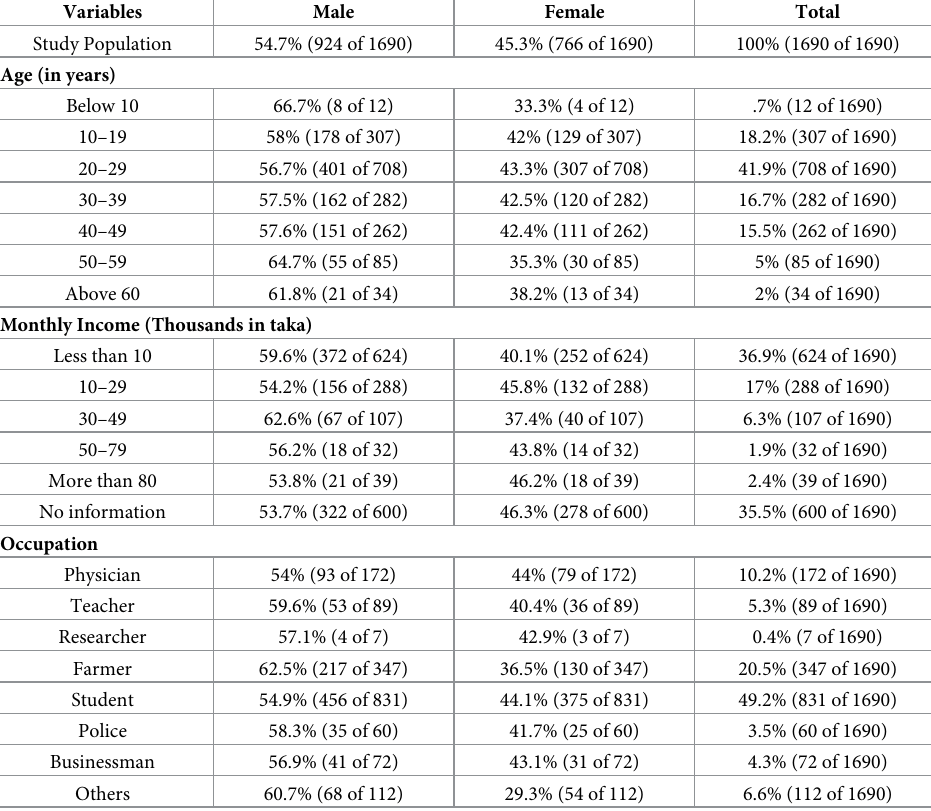
Table 1. Sociodemographic characteristics of the study